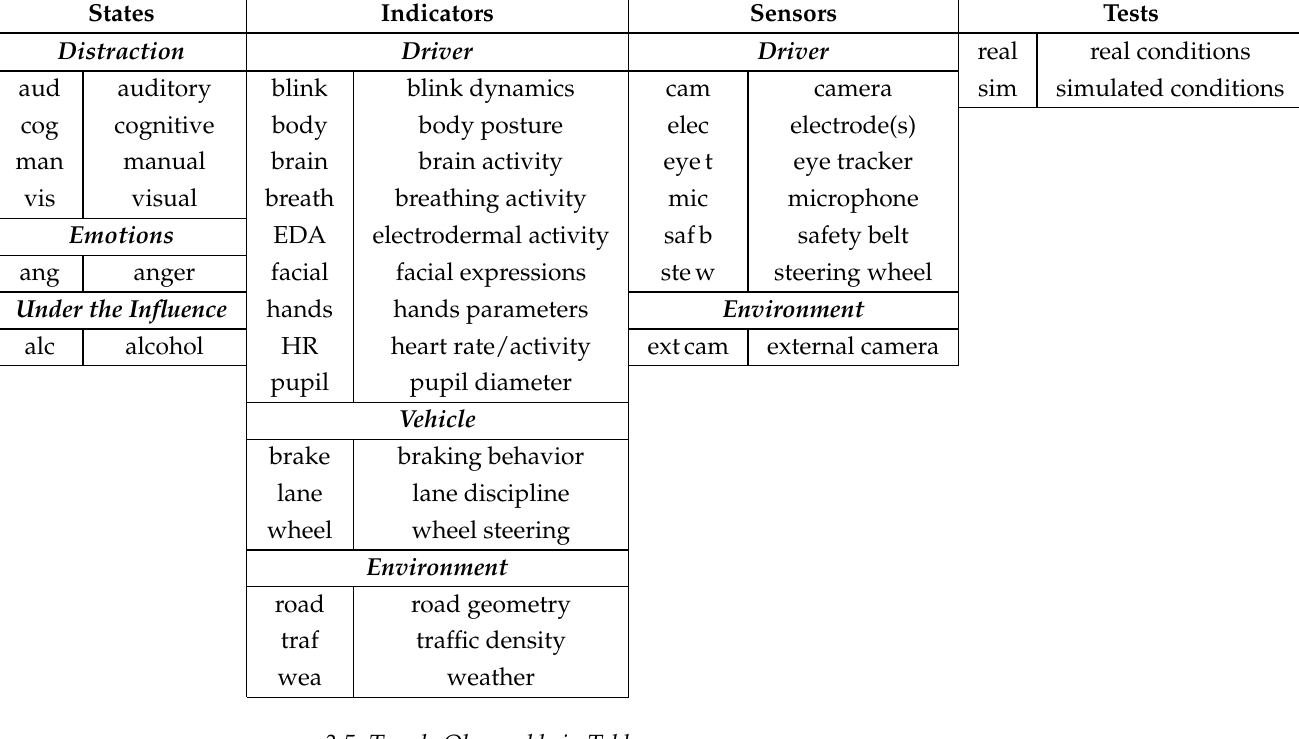
Table 3. The table defines the abbreviations used in Table 2. They are organized according to the megacolumns and columns of Table 2, and are listed in alphabetical